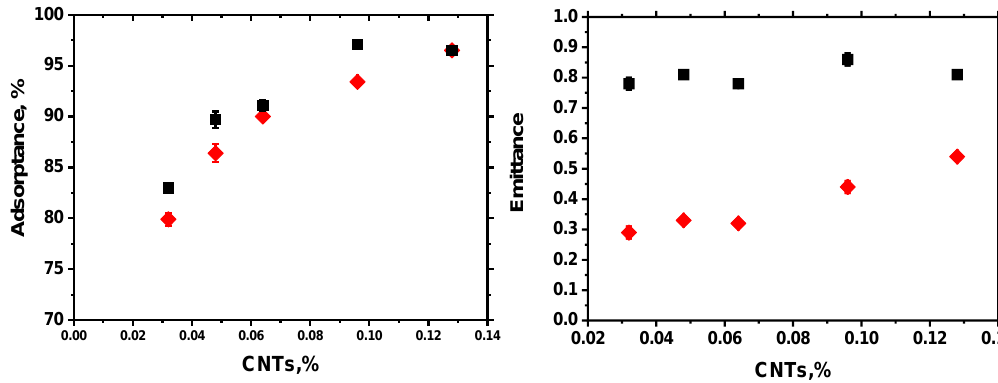
Figure 2. The absorptance and emittance of coatings made of various CNT concentrations, prepared with and without binder composed of boehmite (AlOOH) and polysiloxane (MTMS) with a ratio of 2:1. The binder/CNT weight ratio was 8.4:1 ( ◆ —without binders, █ —with binders).